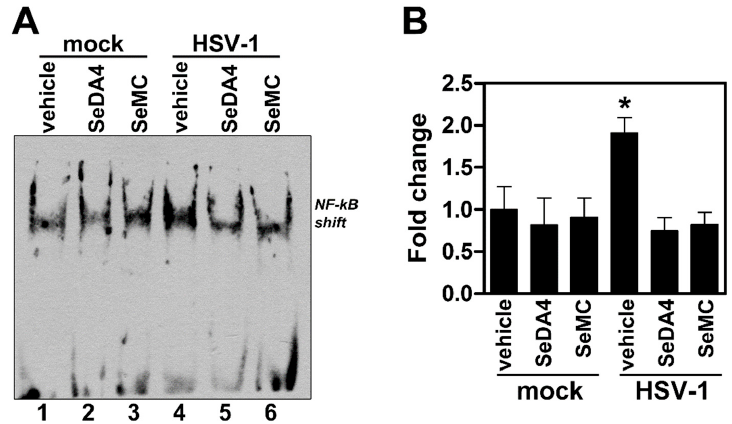
Figure 9. Effects of selenium-based antioxidants on HSV-1-induced NF-kB activation. Nuclear from U937 cells treated with SeDA4 (20 µ M), SeMC (20 µ M) or vehicle alone for 48 h and then exposed or mock-exposed to HSV-1 MOI 50 for further 1 h, were prepared for NF-kB DNA activity by EMSA. ( A ) EMSA gel from one representative experiment. The position of NF-kB DNA shift is indicated. ( B ) Quantitative evaluation of EMSA by densitometry image analysis. Results are expressed as fold change in shift band intensities from all sample versus corresponding mock-infected, vehicle treated samples. Each bar represents the mean value + S.D. of three independent experiments. * p < 0.001 vs mock-infected, vehicle treated